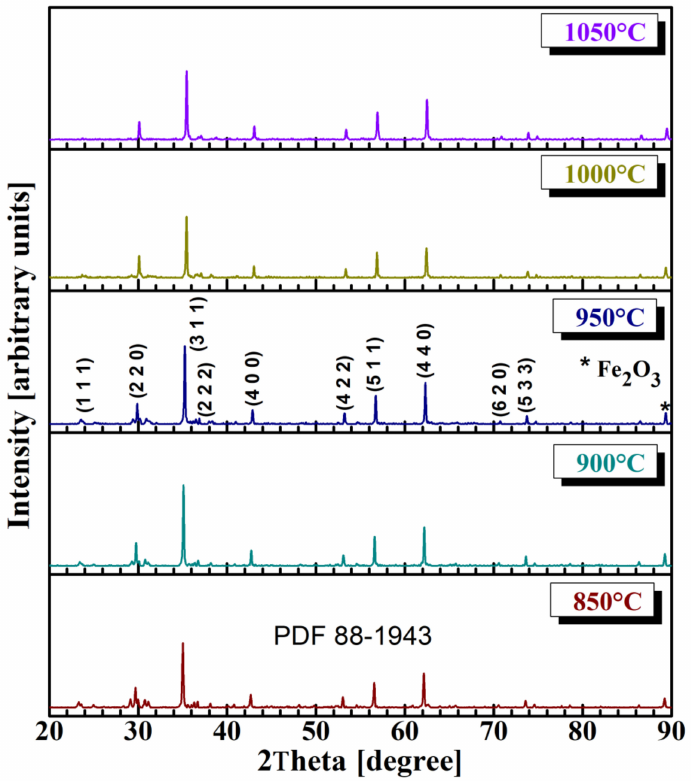
Figure 1. XRD characteristics of Mg 0.5 W 0.5 Fe 2 O 4 powders annealed at various